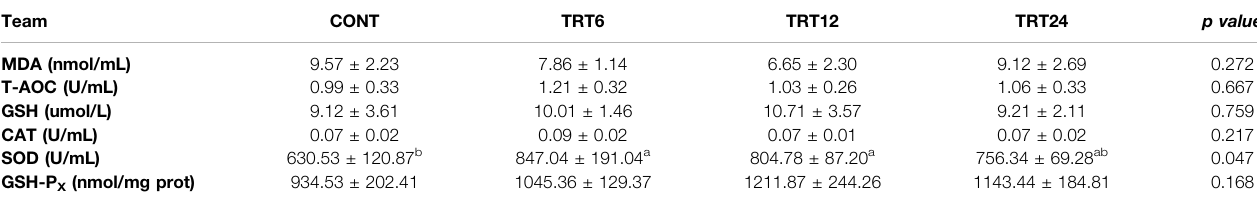
TABLE 8 | Effects of alfalfa-mixed silage fermentation material (AMSFM) on serum antioxidant indexes in meat geese. Control geese (CONT) were fed a basal diet, whereas TRT6, TRT12, and TRT24 were fed a basal diet supplemented with 6, 12, or 24% AMSFM, respectively.